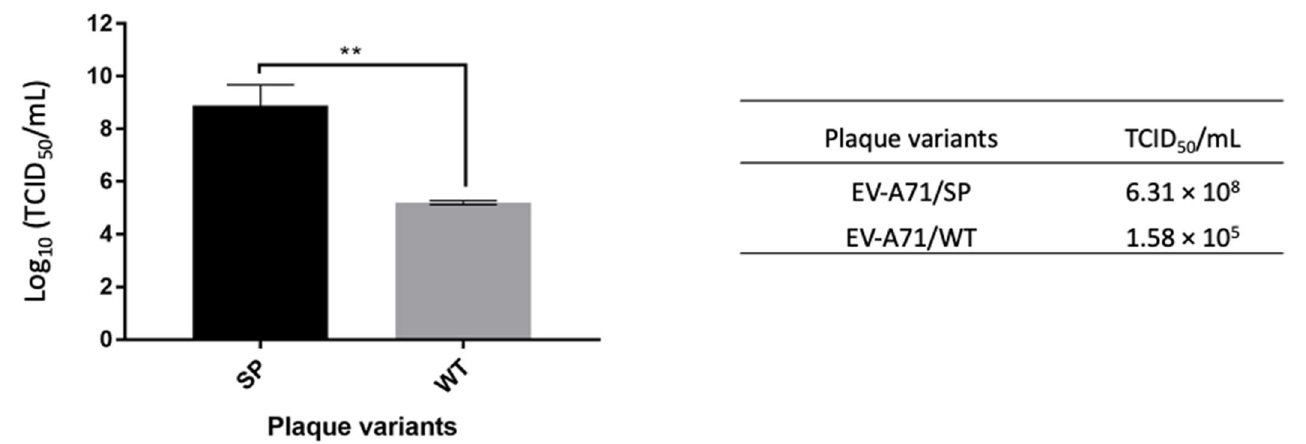
Figure 7. Tissue culture infectious dose (TCID 50 ) of the EV-A71/SP variant compared with the EV-A71/WT. The values were derived from three independent experiments and the average value was presented. Statistical analysis, unpaired t -test, ** p < 0.01.